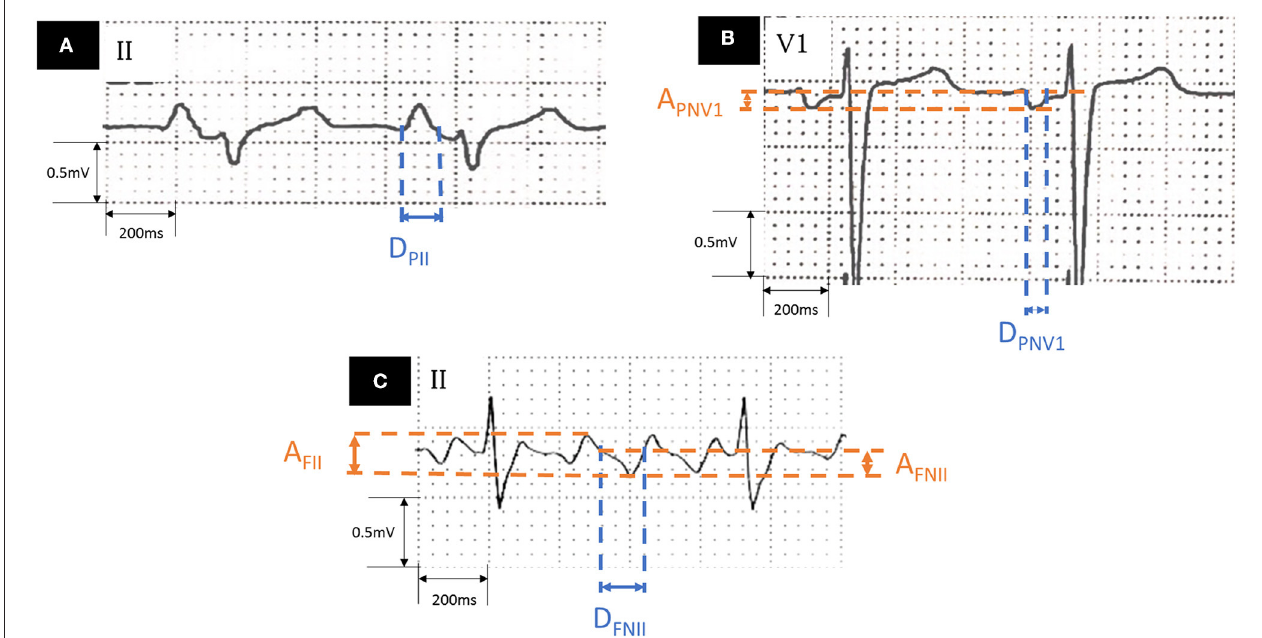
FIGURE 1 | Measurement of ECG parameters. (A) Lead II during sinus rhythm. (B) Lead V1 during sinus rhythm. (C) Lead II during AFL. AFL, atrial flutter; A FNII , amplitude of the negative component of flutter wave in lead II; A PNV1 , amplitude of negative component of the P wave in lead V1 during sinus rhythm; D FNII , duration of the negative component of flutter wave in lead II; D PII , P wave duration in lead II during sinus rhythm; D PNV1 , duration of negative component of the P wave in lead V1 during sinus